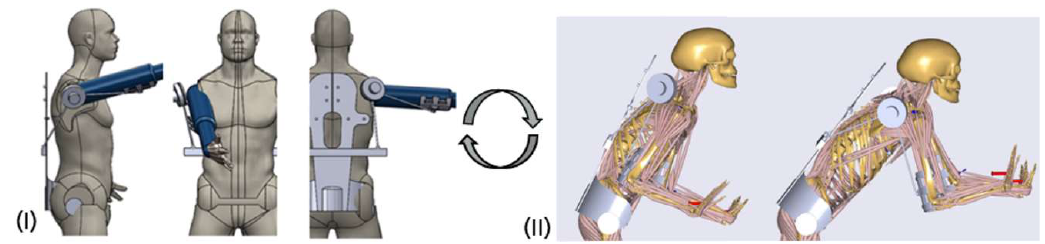
Figure 8. Virtual design frameworks for testing exoskeleton mechanisms ( I ): static human model and ( II ): dynamic multi-body simulation environment.